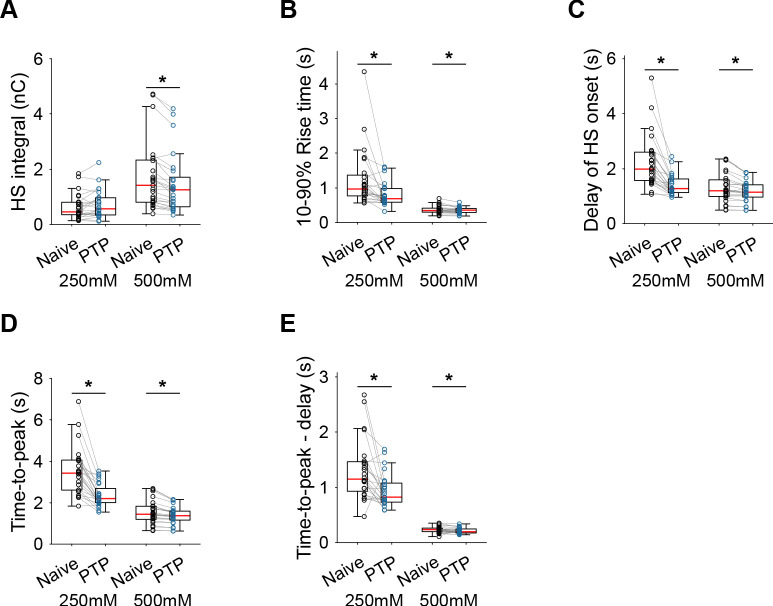
Additional HS parameters before and after PTP in WT neurons.(A) Integral of current from HS-induced release at different concentrations. (B) 10–90% rise time of peak HS-induced current. (C) Time delay after application of HS before onset of release. (D) Time from start of HS application till peak HS-induced current. (E) Time from start of HS application till peak HS-induced current, corrected for the delay in release onset after HS application. All panels comparing before (Naive) and after PTP in WT (*p<0.05, Wilcoxon signed-rank test).
Figure 4—figure supplement 1—source data 1.Statistics overview.